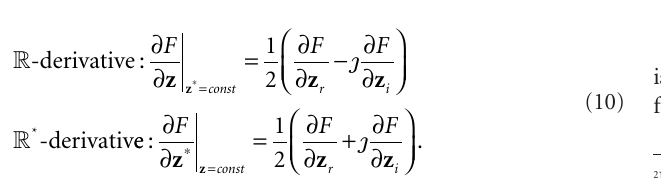
FiGurE 1 | illustration of white circular and doubly white complex-valued noises. (A) Scatter plots of complex white noise realisations. Top row: circular Gaussian noise (left) and non-circular Gaussian noise ( r =0.81) (right). Bottom row: circular Laplacian noise (left) and non-circular Laplacian noise ( r = 0.81) (right). The circularity measure r is defined in (8). The kurtosis values Kc are given for each case. (B) Power spectra (thick gray line) and pseudo-power spectra (thin gray line) of complex Gaussian noises with varying degrees of non-circularity r = {0, 0.8, 1}.